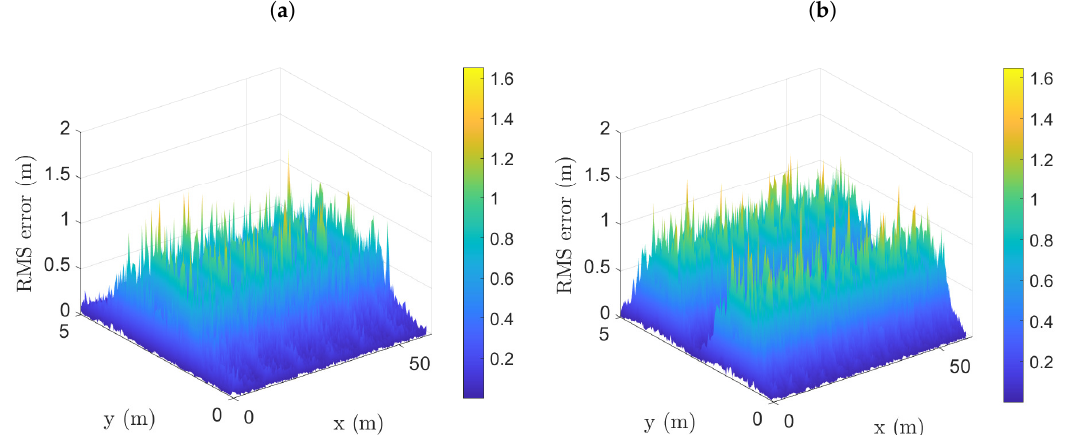
Figure 6. ( a ) x -axis RMS error distribution and ( b ) y -axis RMS error